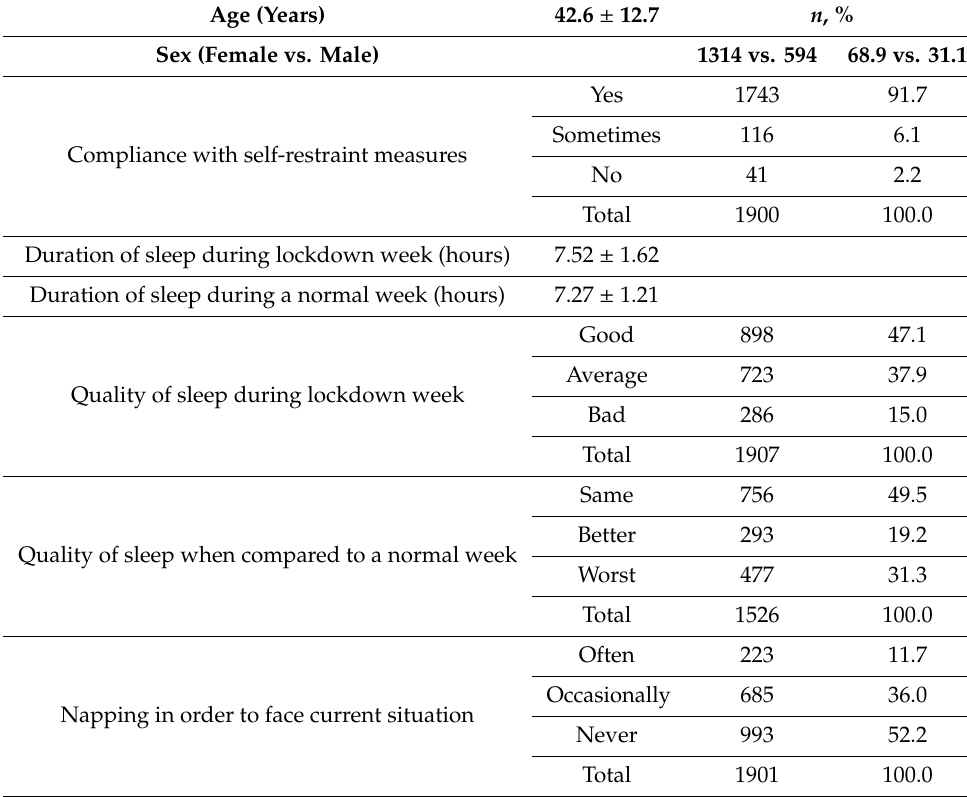
Table 1. Demographic and sleep data of the study population ( n = 1908).